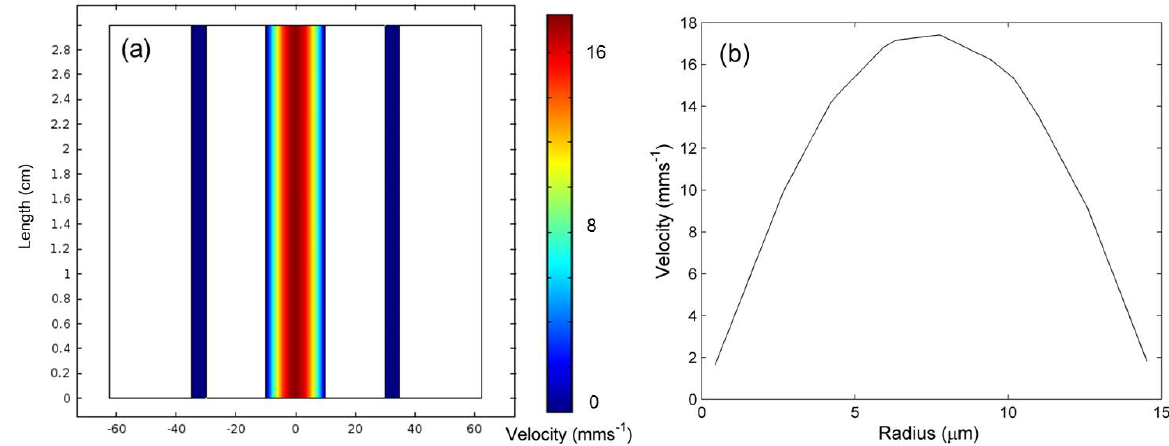
Figure 2. ( a ) The velocity cross-section for the entire MOF geometry and ( b ) the velocity profile with, expected, laminar